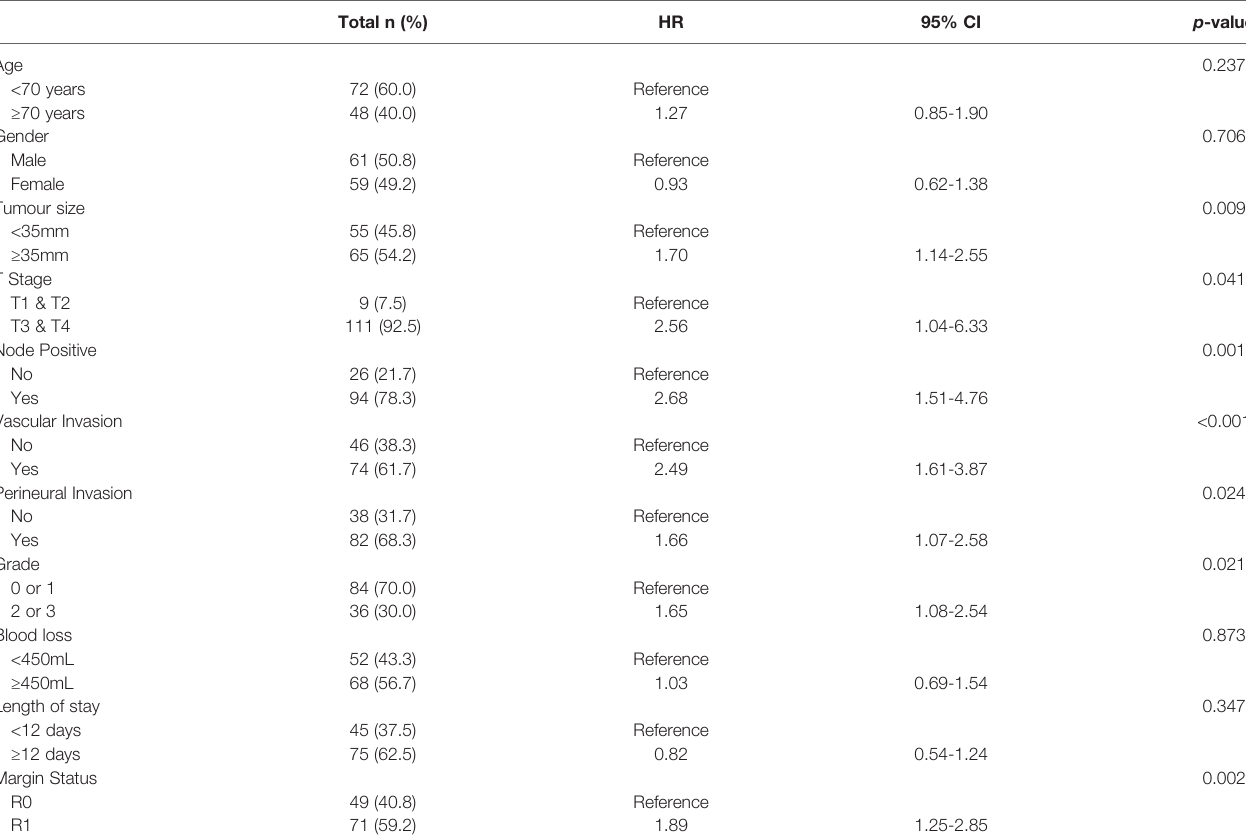
TABLE 1 | Patient and tumour characteristics and correlation with survival